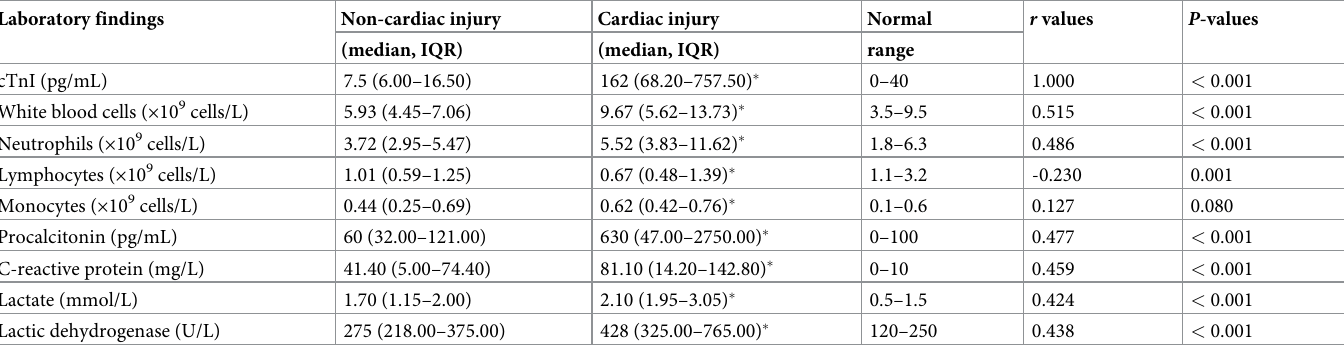
age, gender, clinical category, symptoms, and comorbidities between patients with or without elevated blood pressure. Compared with the patients without elevated blood pressure, the level of cTnI and procalcitonin in the 16 patients rose significantly (median [interquartile range]: Table 2. The laboratory findings of COVID-19 patients with or without cardiac